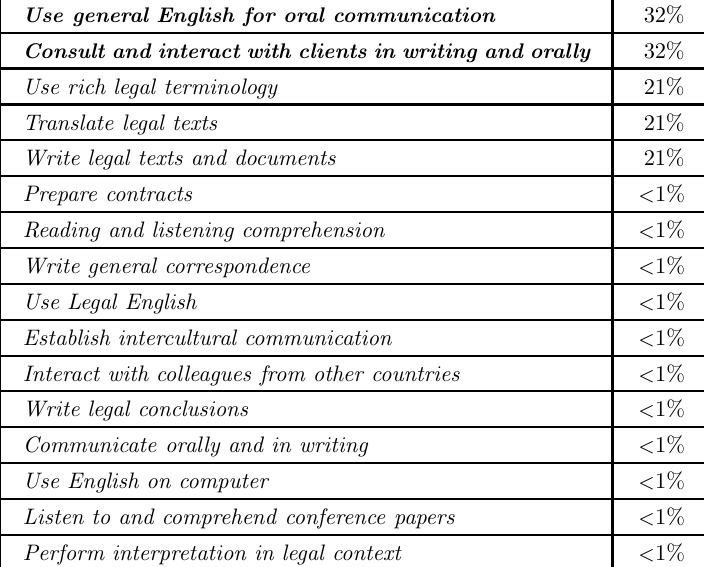
Functions of English most necessary in participants’ work context Use general English for oral communication